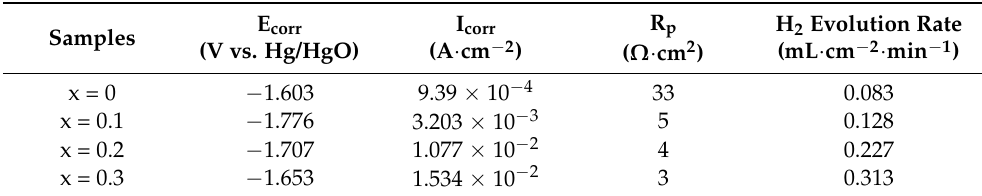
Table 3. The corrosion parameters of the Al-1Zn-0.1In-0.1Sn-0.5Mg-xMn (x = 0, 0.1, 0.2, 0.3) (wt.%) alloy anodes in the 4 M NaOH